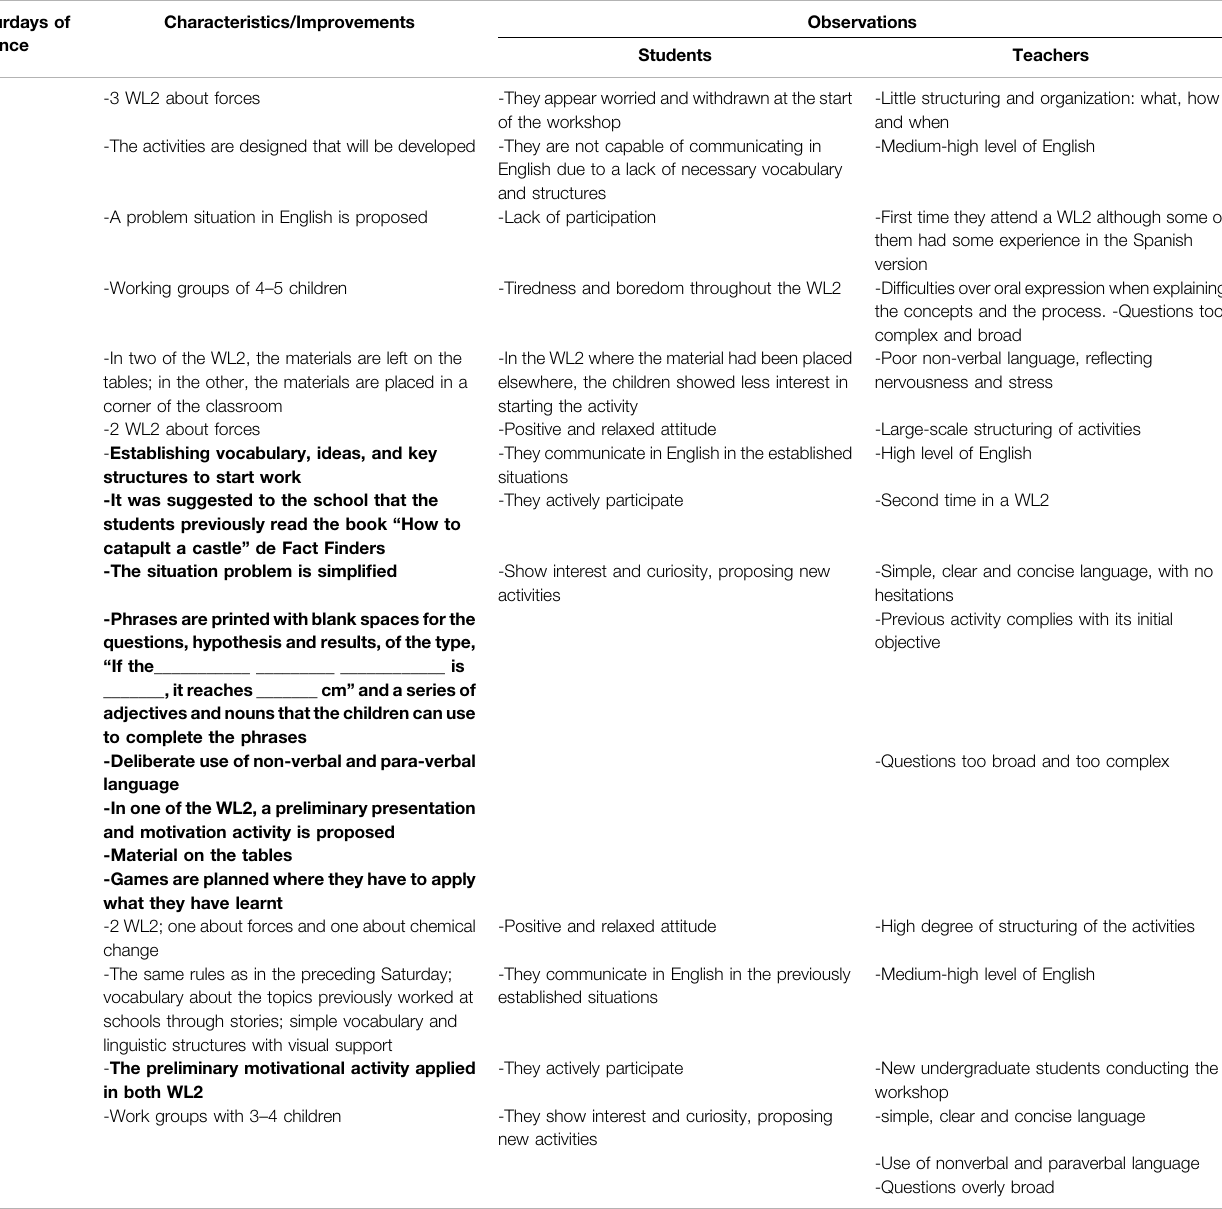
TABLE 2 | Main characteristics of the WL2 of each Saturday of Science and observations from fi eld notes and systematic observation. Saturdays of